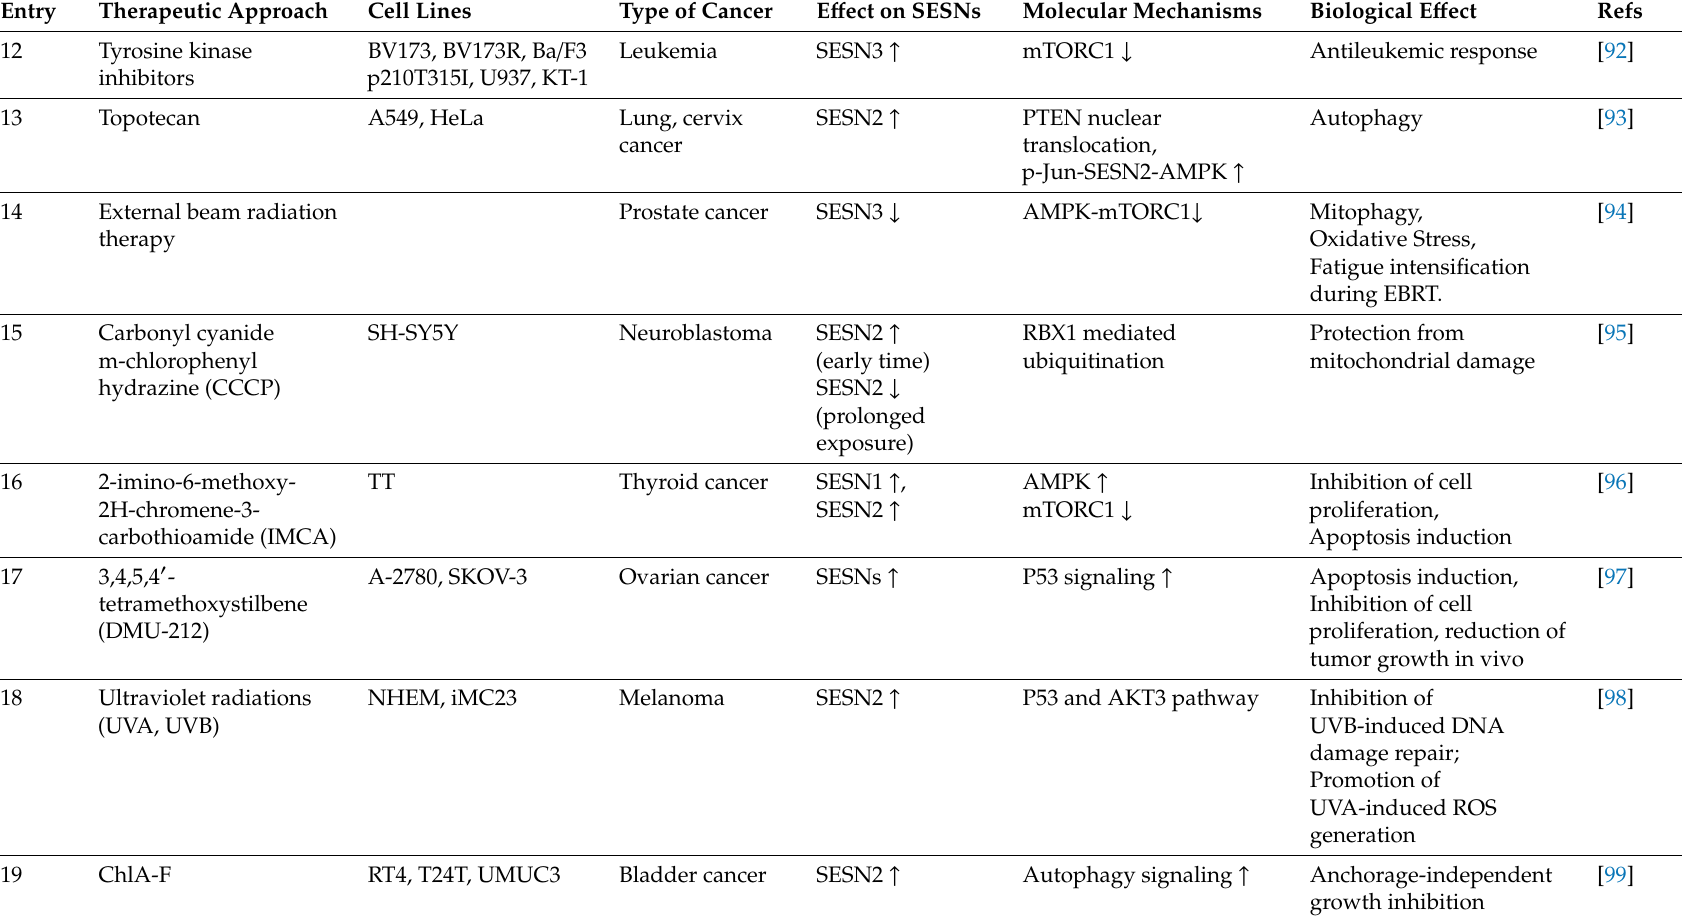
Table summarizing literature on chemotherapeutics targeting expression levels and / or function of SESNs in di ff erent tumor cell lines and cancer types. Impact on either aspect of SESN biology is denoted as ↑ (increased SESN expression or increased downstream function) and ↓ (decreased SESN expression level or attenuated downstream function). Specific consequences for tumor cell survival is indicated when